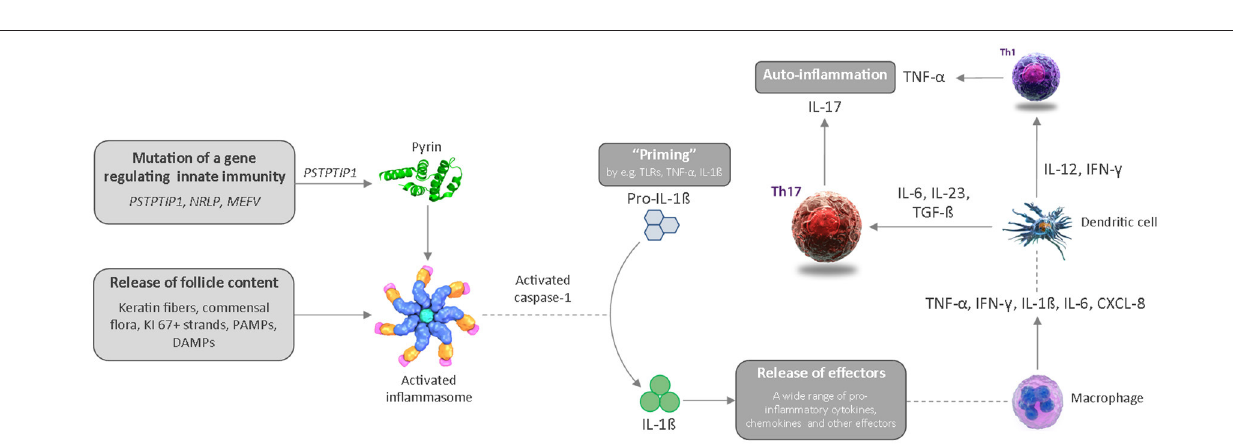
Frontiers in Immunology |